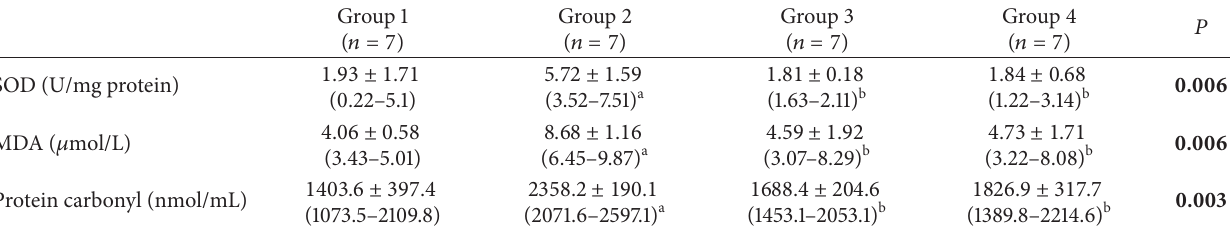
Table 3: Serum SOD, MDA, and PC levels of all groups.